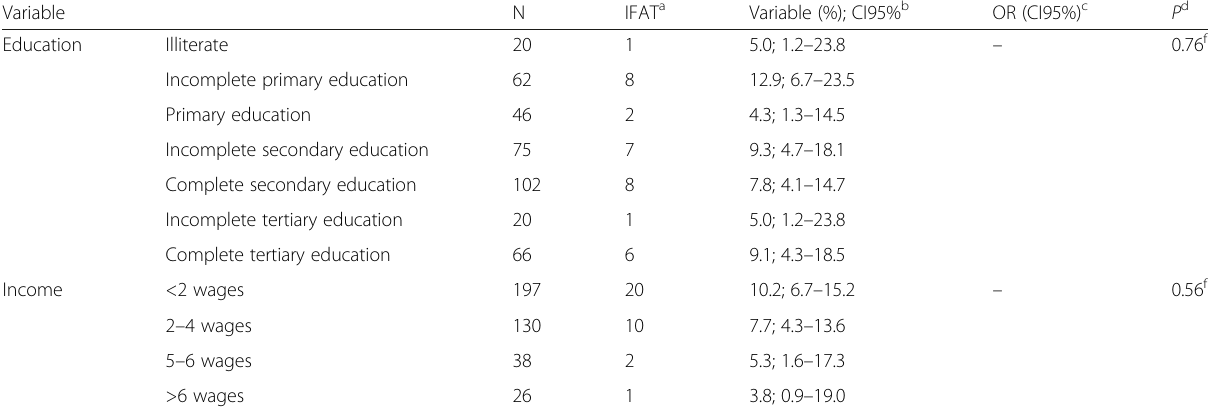
Table 2 Association between the social condition of the owners (education and income) and the detection of antibodies against Leishmania major by IFAT